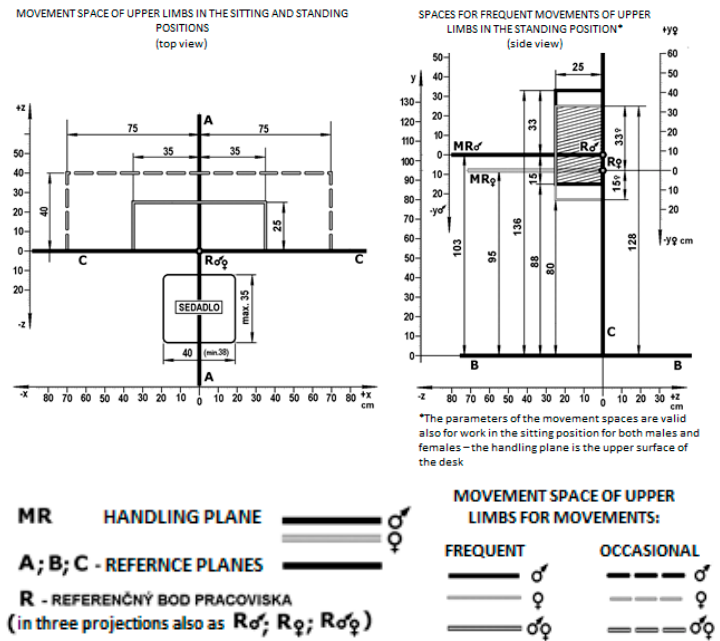
Figure 3. Space for movements of the upper limbs at [9].